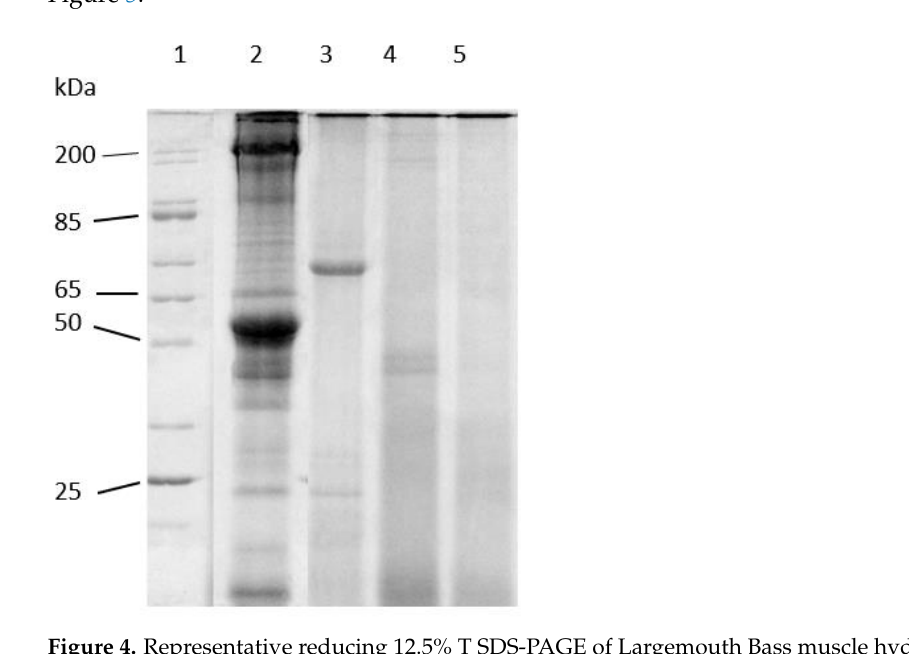
Figure 4. Representative reducing 12.5% T SDS-PAGE of Largemouth Bass muscle hydrolysis over time. Lanes (1) broad range molecular wgt standard (200–10 kDa); (2) intact fish muscle; (3) 1.5 h hydrolysis; (4) 3 h hydrolysis; (5) 6 h hydrolysis.